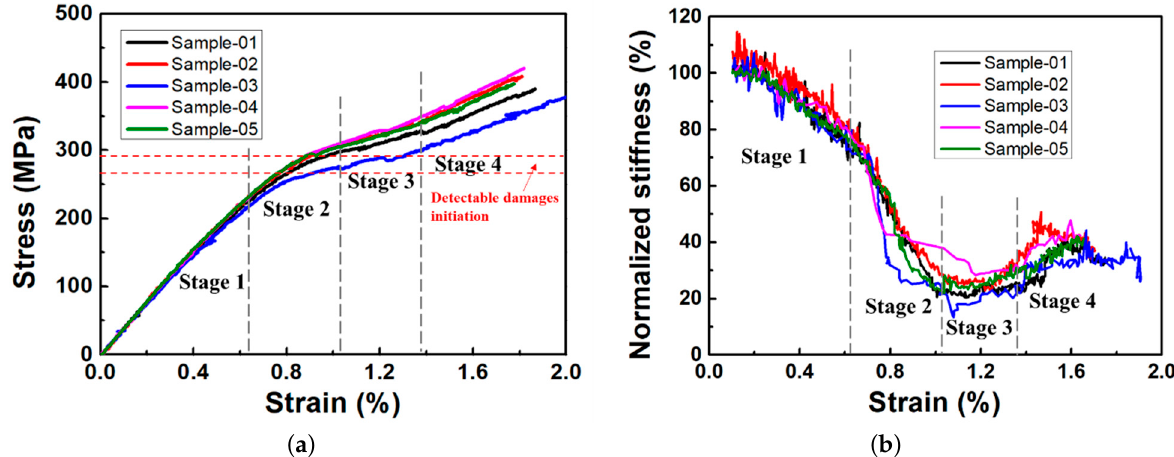
Coatings 2021 , 11 , x FOR PEER REVIEW Figure 4. The typical stress–strain curves ( a ) and the normalized stiffness–strain curves ( b ). Table 2. Mechanical properties generated from Step 1.